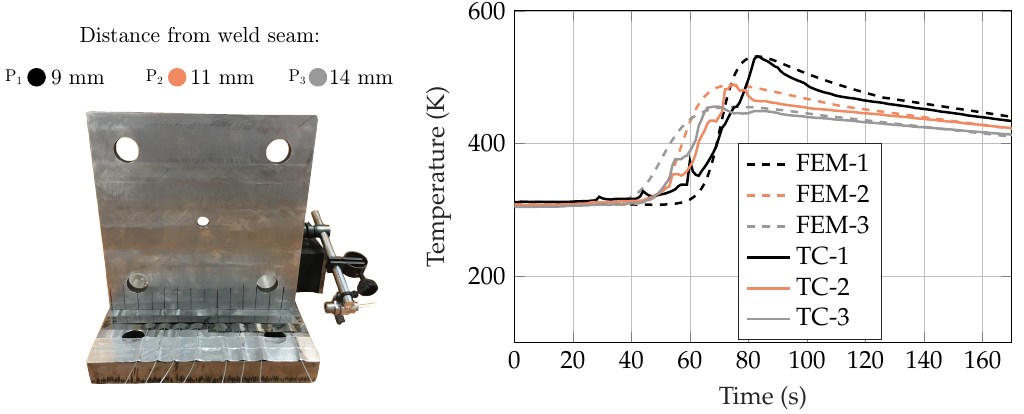
Figure 15. Comparison between experimental and numerical results of temperature over